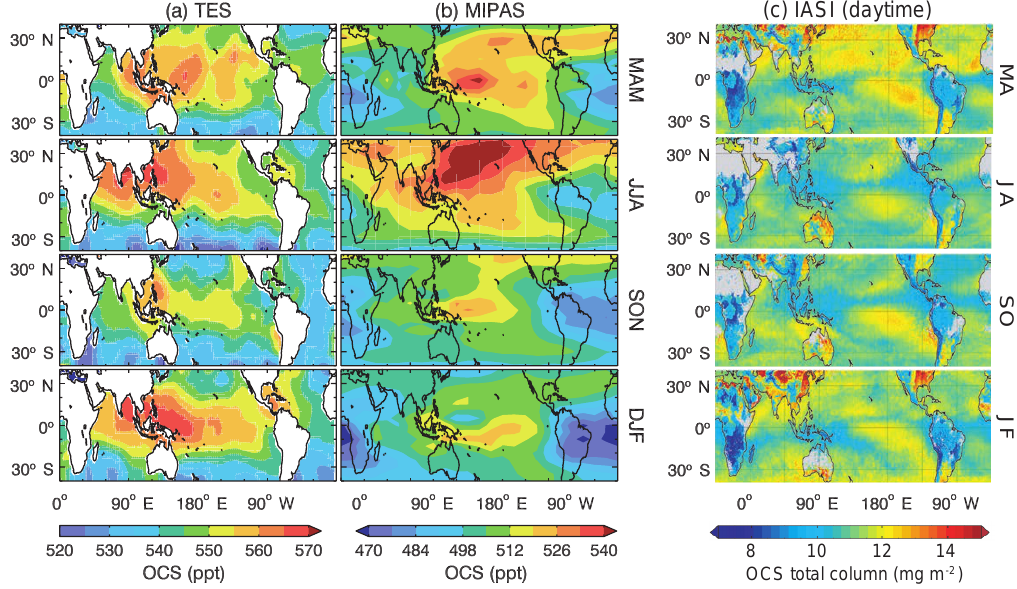
Figure 13. Comparisons of the seasonal horizontal distribution of OCS retrievals. (a) TES averaged between 200 and 900hPa, obtained using TES Level 2 swath OCS retrievals in 2006, averaged over four seasons (March to May, June to August, September to November, and December to February). (b) MIPAS (250hPa), using MIPAS Level 2 swath retrievals from 2002 to 2011. The data in (a) and (b) have been averaged to the same 5 ◦ longitude × 4 ◦ latitude grid boxes and have been smoothed to a 20 ◦ × 20 ◦ spatial resolution. (c) Two-month averages of IASI daytime OCS total column retrievals from 2014 with resolution 0 . 5 ◦ × 0 . 5 ◦ , extracted from Vincent and Dudhia (2017). Missing data are represented by white areas in panels (a) and (b) and by gray areas in panel (c) .